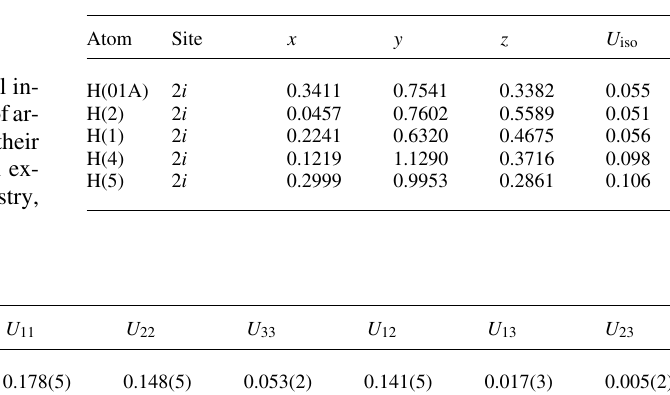
Table 2. Atomic coordinates and displacement parameters (in Å 2 ) .